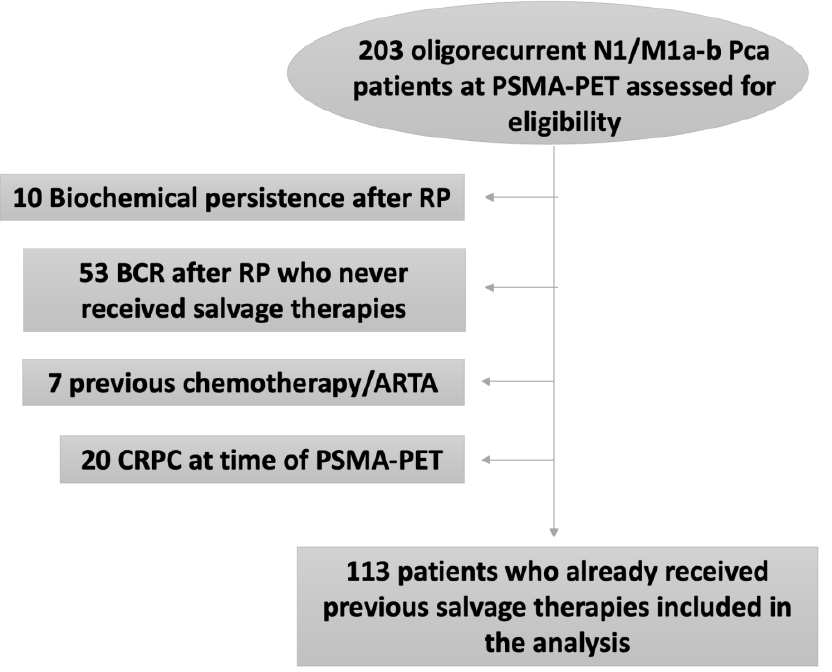
Figure 1. Flow chart of participants in the study .